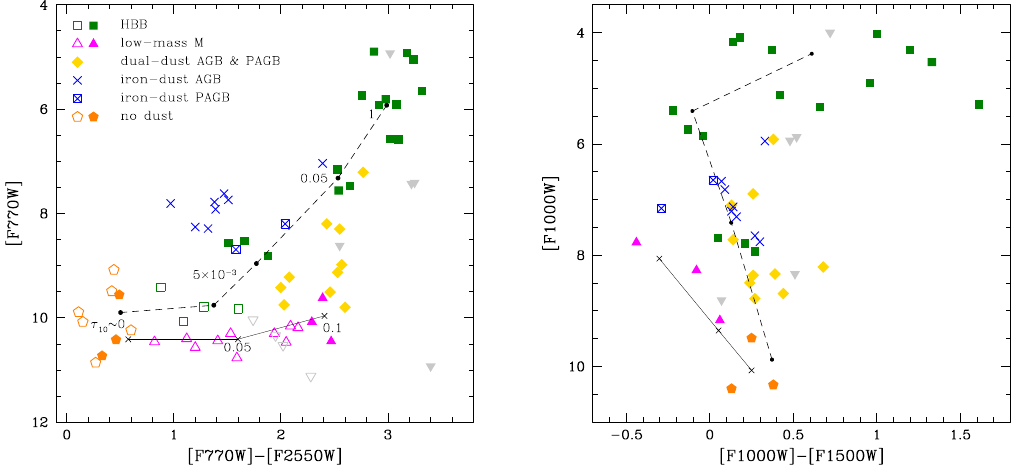
Figure 3. Distribution of M-type AGB stars in the LMC in the colour-magnitude ([F770W] − [F2550W], [F770W]) (left panel) and ([F1000W] − [F1500W], [F1000W]) (right) diagrams. Empty symbols indicate stars with the IRS spectrum limited to λ < 14.2 µ m, for which [F2550W] was taken as the MIPS 24 µ m magnitude. Grey triangles indicate points whose SED could not be reproduced by sinthetic modelling; orange pentagons indicate dust-free M stars. Green squares refer to M > 3.5 M (cid:12) stars, which experience HBB during the AGB phase. Blue squares filled with crosses and some of the yellow diamonds are interpreted as stars that left the AGB and are currently evolving through the post-AGB phase. Solid and dashed tracks indicate the evolution of models stars of 1.5 M (cid:12) and 5 M (cid:12) , respectively. The numbers along the sequences in the left panel indicate the corresponding values of τ 10